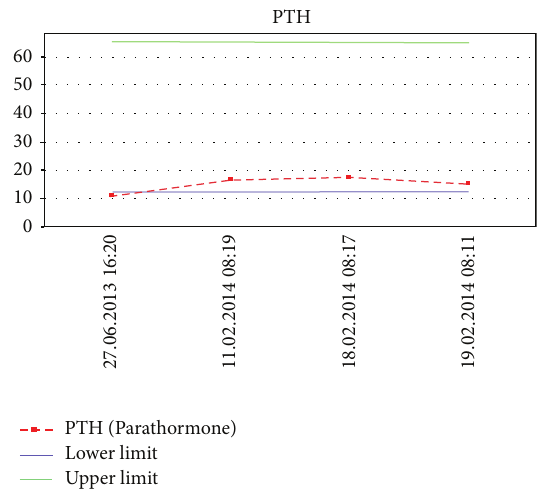
Figure 1: Serum calcium concentrations showing temporary remis- sion of hypercalcemia.